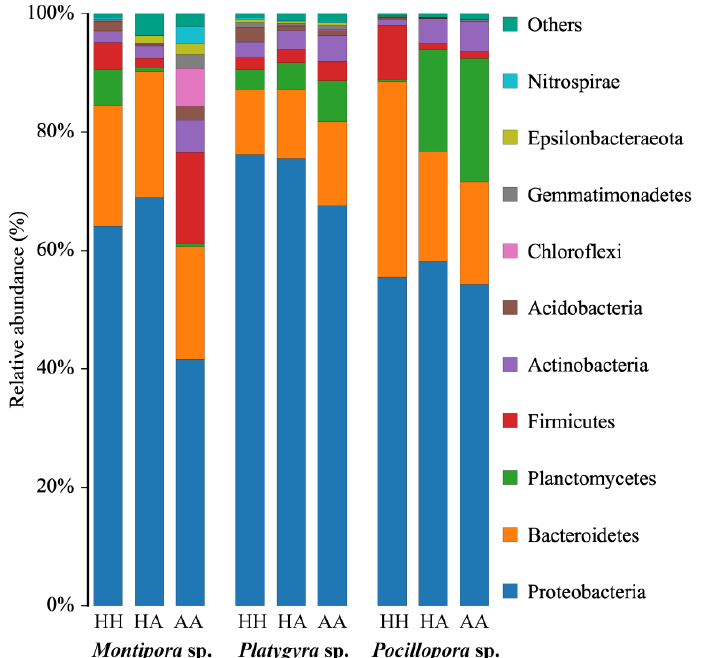
Figure 3. Relative abundance (%) of major bacterial communities at the phylum level.